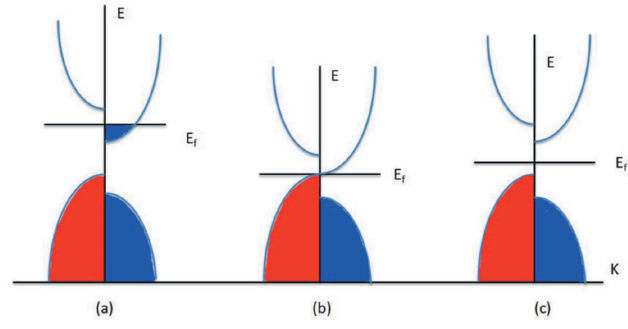
Figure 1 Schematic representations of the density of states (DOS) for ( a ) half- metals, ( b ) spin-gapless semiconductors and ( c ) magnetic